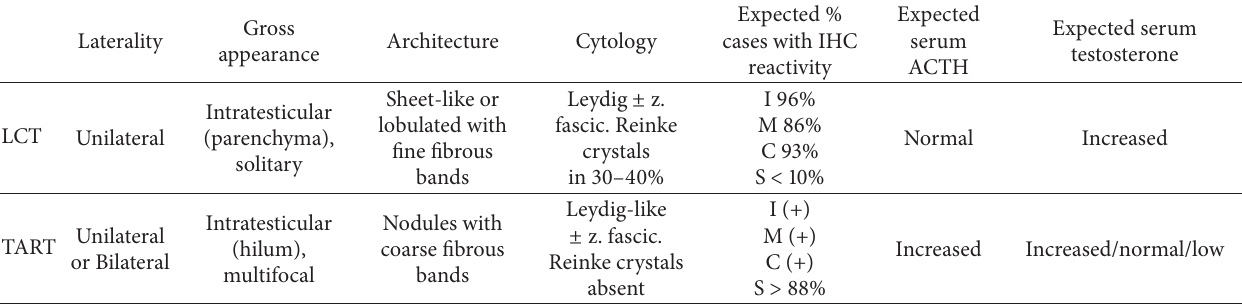
Expected serum testosterone